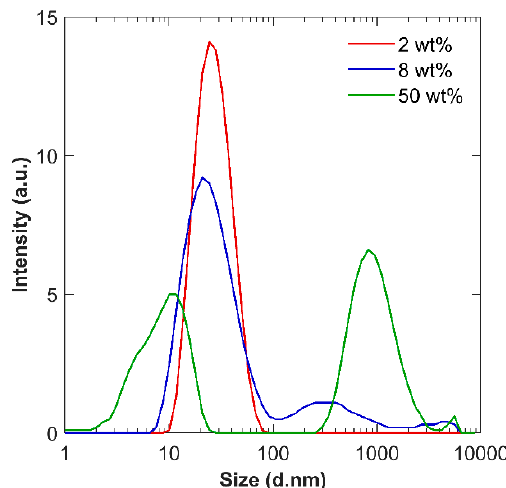
Figure 4. Selected particle size distribution (PSD) of dilution of NS-20b demonstrating the transition from bimodal to monomodal distributions.